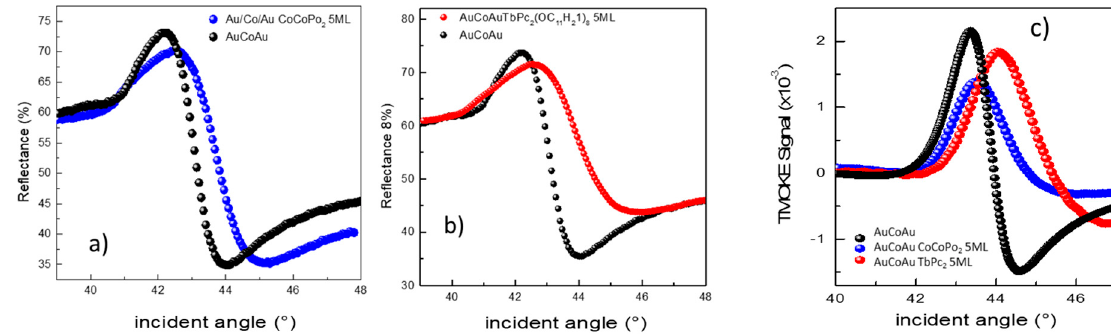
Figure 9. ( a , b ) Experimental reflectivity curves (SPR) vs. angle of incidence of TbPc 2 (OC 11 H 21 ) 8 and CoCoPo 2 macrocycles. ( c ) Magneto-plasmonic curves (TMOKE signal) of Au/Co/Au transducers covered by 5 monolayers (5ML) of TbPc 2 (OC 11 H 21 ) 8 and CoCoPo 2 , respectivley.